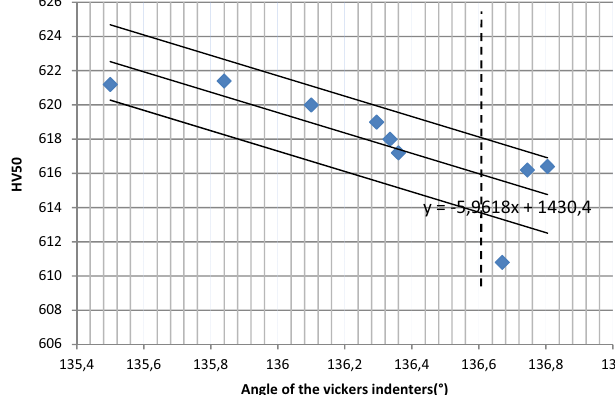
Fig. 4. (Color online) Relation between angle of the indenter and hardness value (620 HV50).